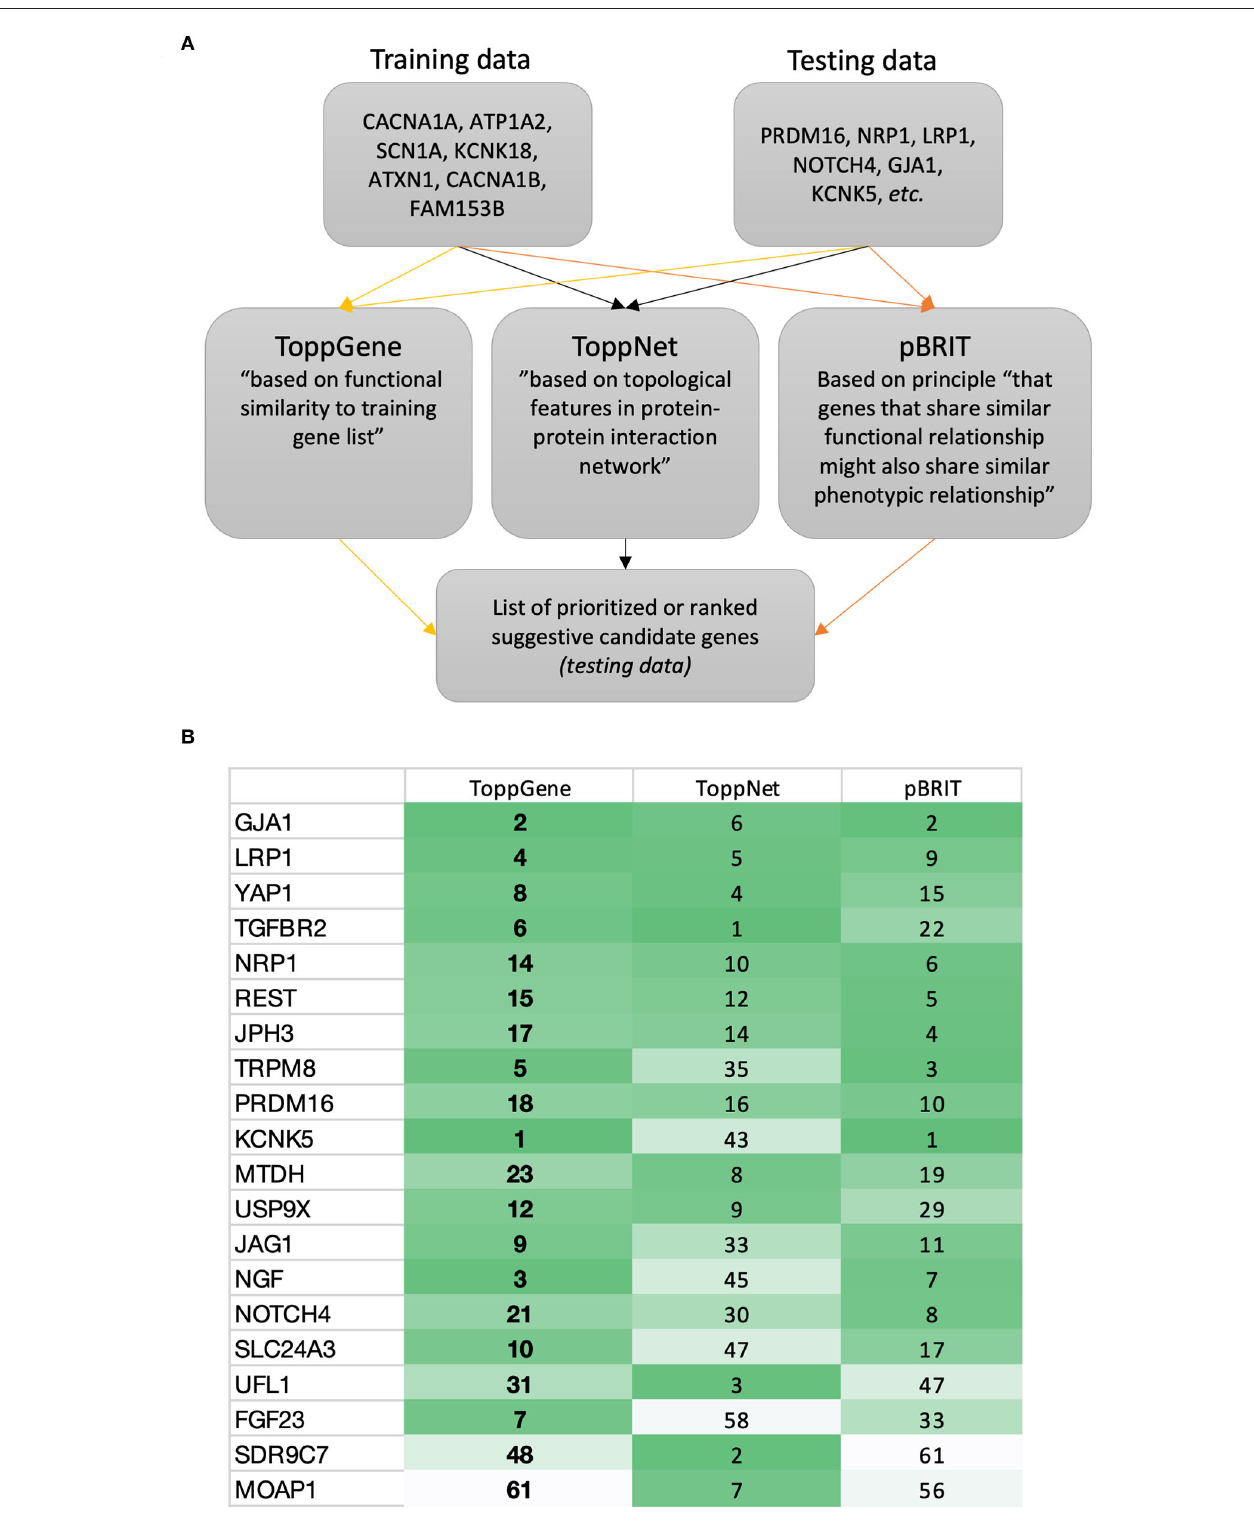
FIGURE 1 | Proposed gene prioritization for future GWASs. (A) Suggested gene prioritization workflow. According to the described approach (i.e., creating training data focused on known familial migraine genes), the gene prioritization strategy will seek to prioritize suggestive candidate genes in relation to the genes forming the training data. This prioritization may be based on features such as similarity (e.g., focused on genetic sequence, involvement in biological pathways, or accompanying